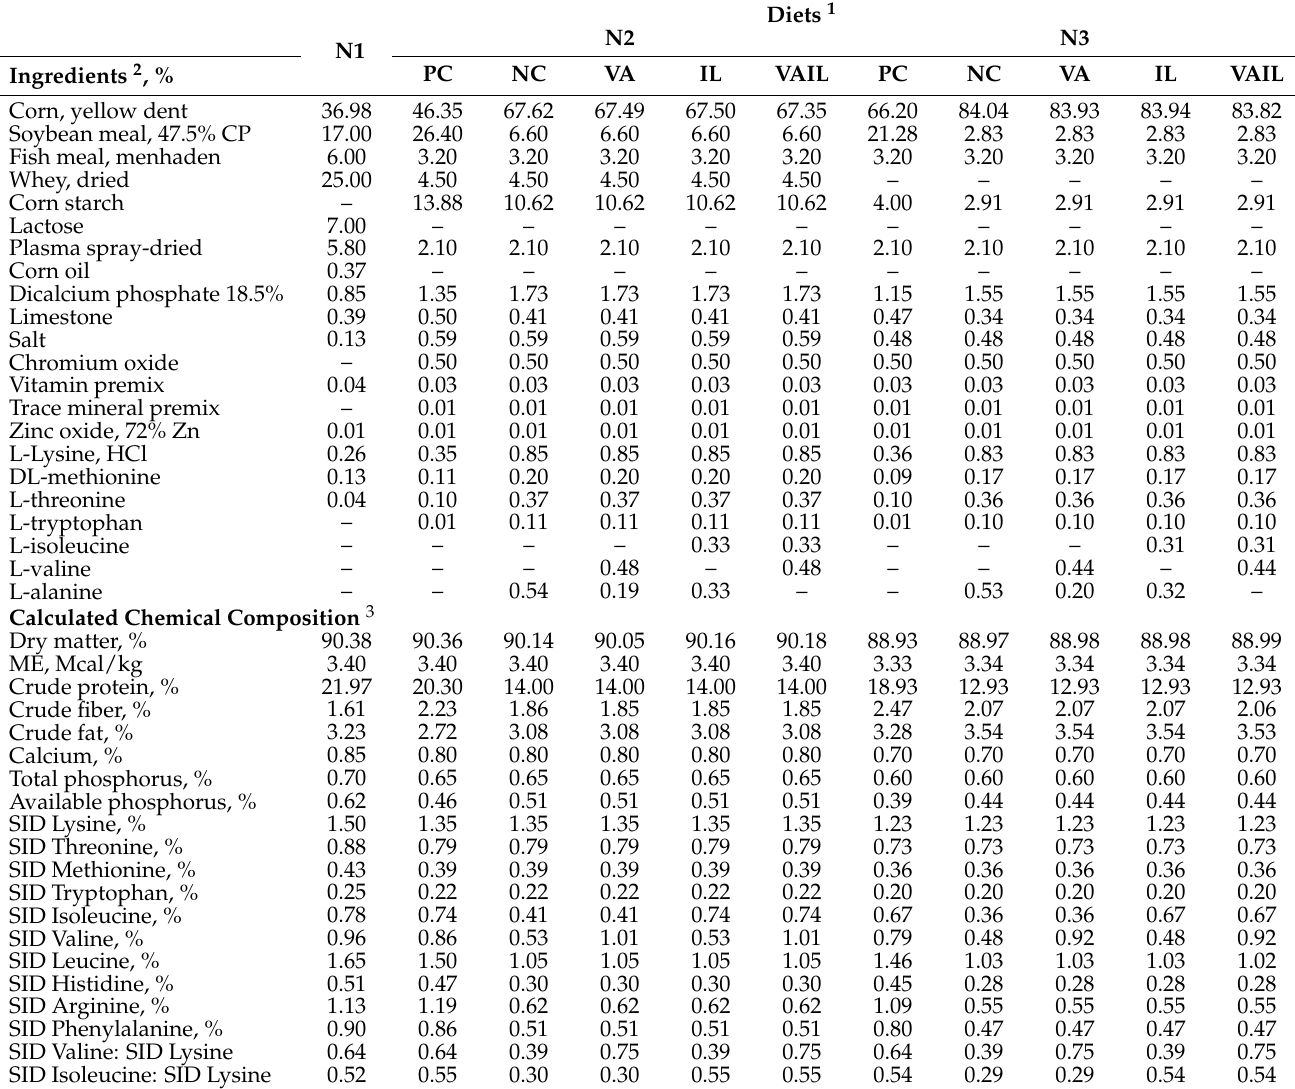
Table 4. Experimental diets’ ingredients and calculated chemical composition (as-fed